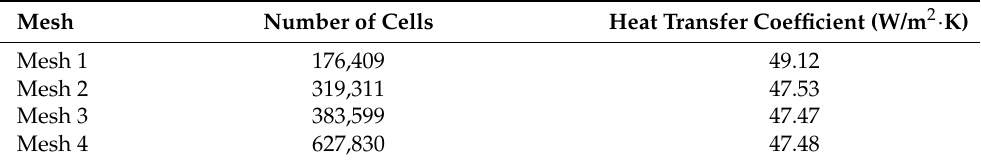
Table 4. Mesh sensitivity analysis at wind speed of 7 m/s and solar irradiance of 800 W/m 2 .